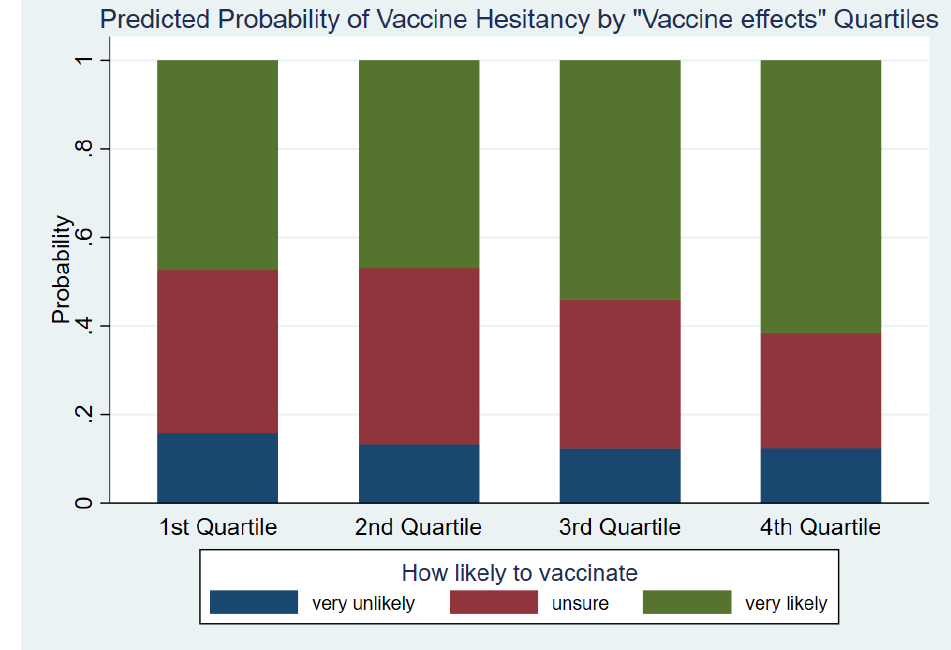
Figure 2. Predicted Probability of Vaccine Hesitancy by “Vaccine effects” Quartiles.